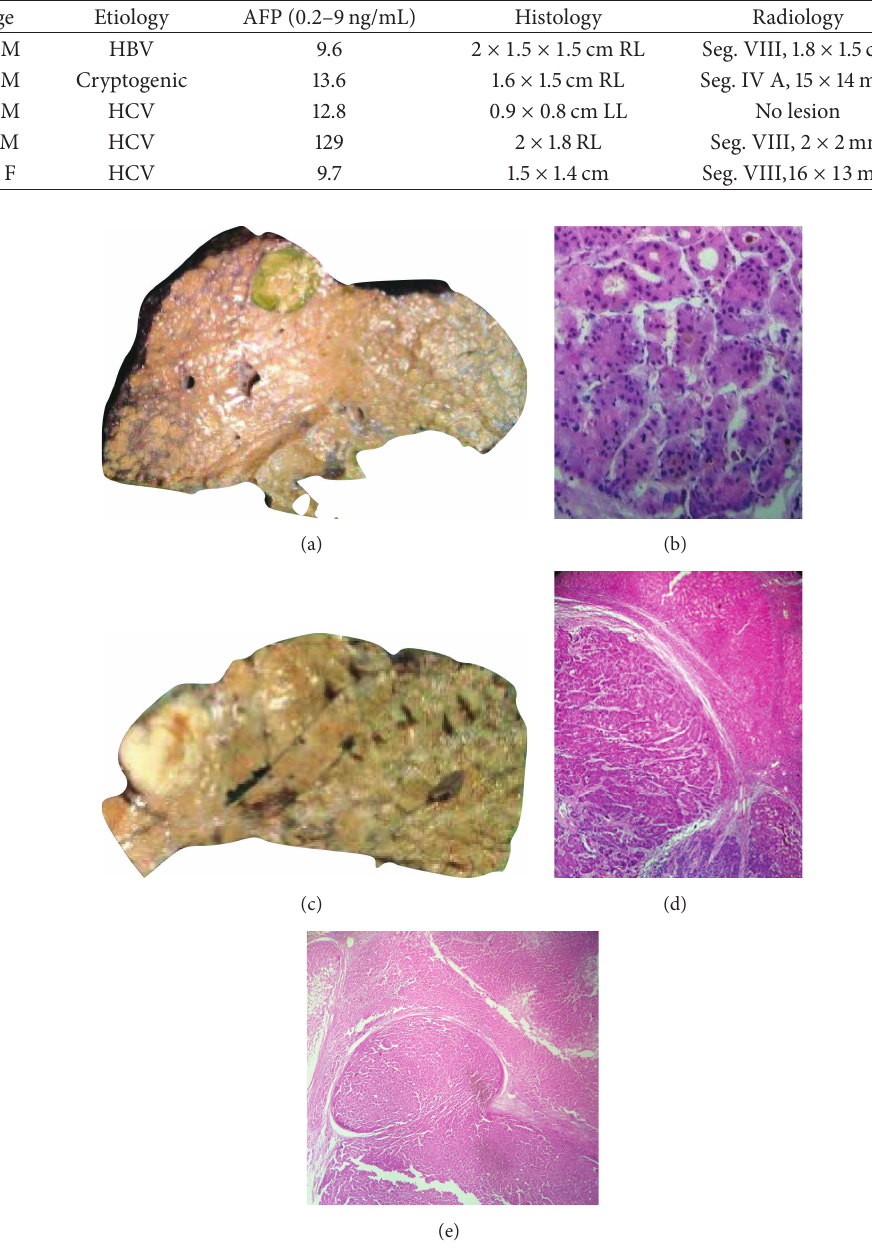
Figure 1: (a) Small HCC in liver explant. (b) Photomicrograph showing neoplastic hepatocytes in pseudoacinar pattern (H&E × 40). (c) Small HCC in liver explant. (d) Photomicrograph showing thick trabeculae of neoplastic hepatocytes (H&E × 20). (e) Mushrooming phenomenon of small